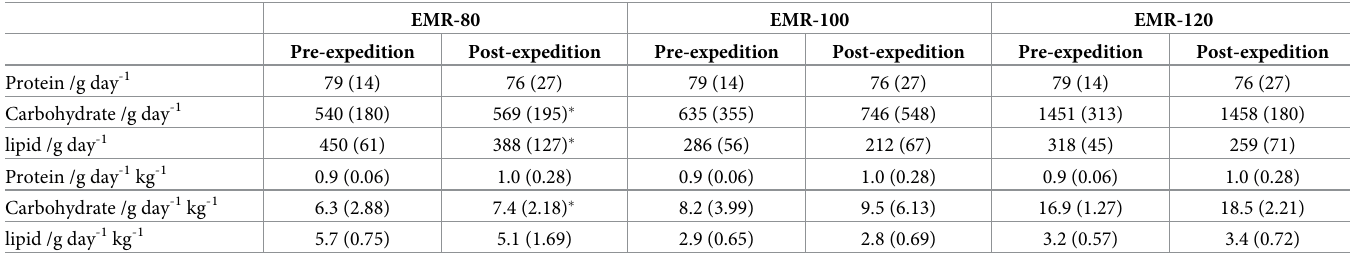
Table 6. Average [median (IQR)] substrate utilisation pre- and post-expedition for the three exercise intensities where EMR-80, EMR-100 and EMR-120 are the measurements whilst exercising at 80 steps min -1 , 100 steps min -1 and 120 steps min -1 , respectively; unaltered and normalised to total body